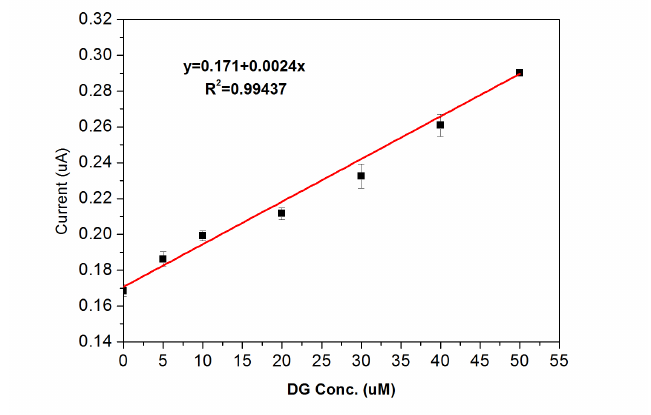
Figure 12. Calibration curve obtained at 240 s for the DG measurement in 1:1 bovine serum-buffer